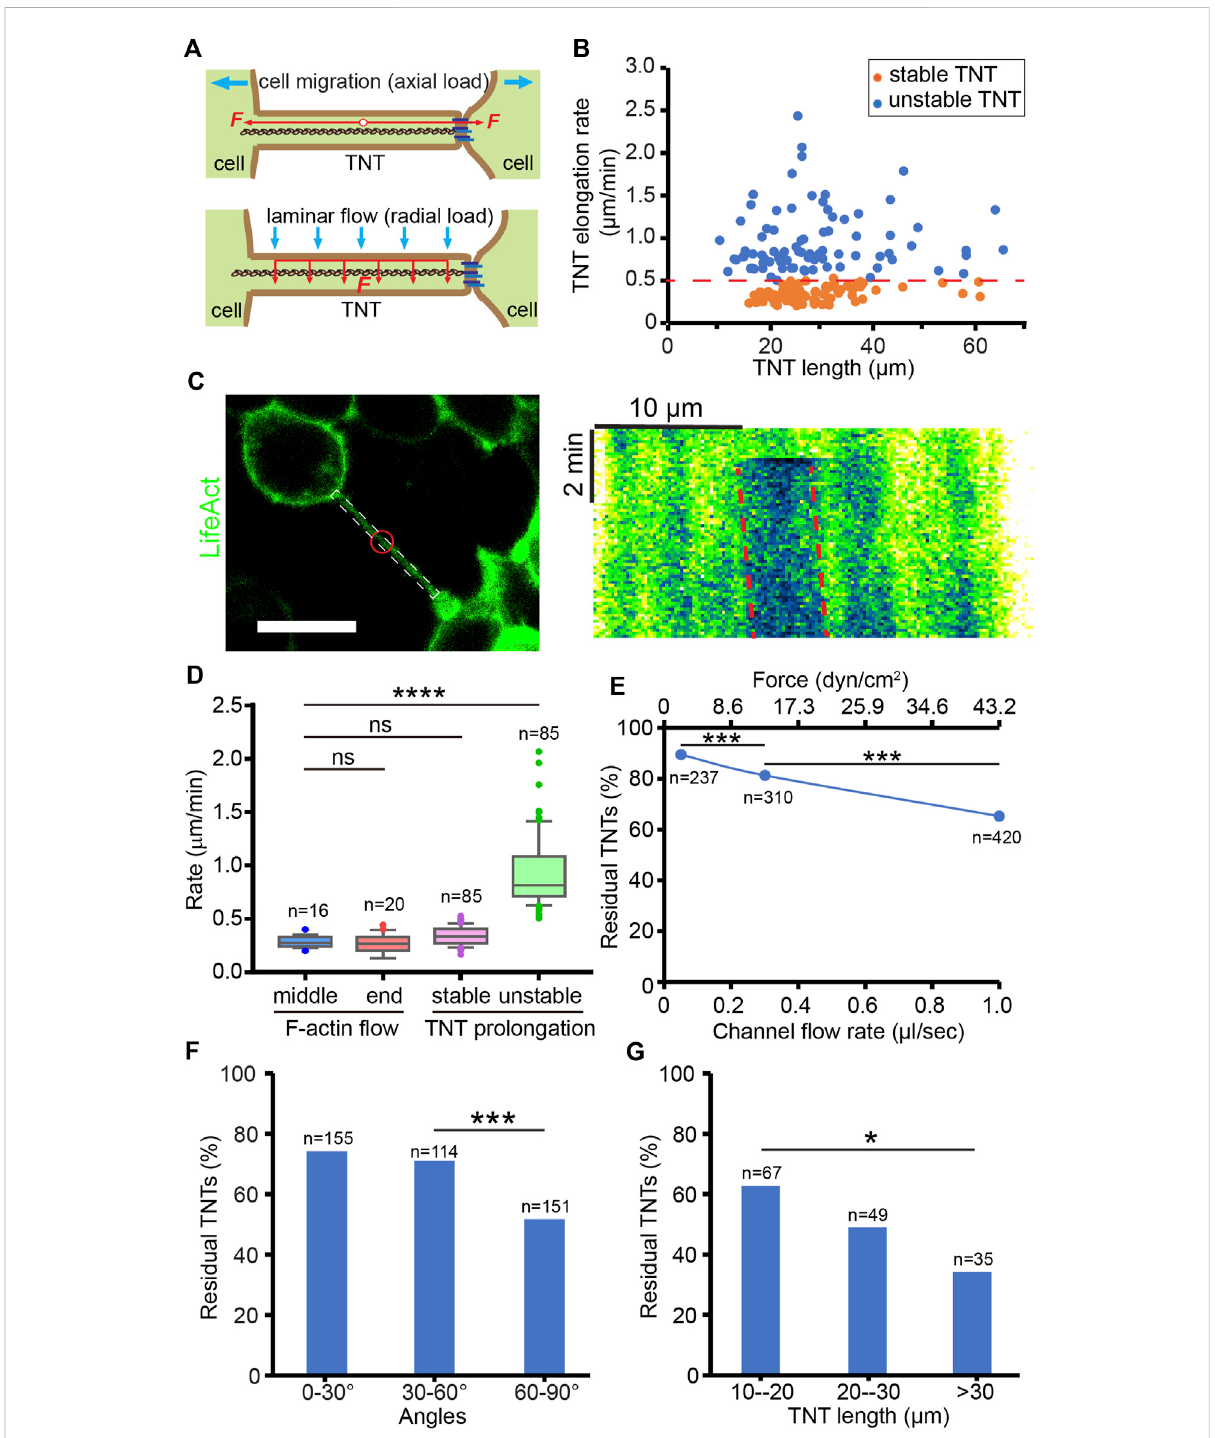
FIGURE 3 MechanicalstabilityofTNTs. (A) SchematicdiagramoftheaxialandradialloadofaTNT. (B) ElongationrateofstableandunstableTNTsinduced by TNT-connected cell migration. (C) Analysis of F-actin fl ow in a LifeAct-positive TNT. Red circle indicates the bleached area. Scale bar, 20 μ m. Kymograph generated from the white boxed area in the left image shows the movement of the bleached area (red dash lines) in the TNT, where the x-axis is the scale bar of length, and the y-axis is the scale bar of time. (D) Comparison of the fl ow rate of F-actin in the middle and end position of TNTs and the elongation rate of stable and unstable TNTs. (E) The percentage of residual TNTs after different fl ow stress treatments. (F) Effect of fl ow stress (1 μ l/s) on the number of TNTs with different angles. (G) Longer TNTs (60 – 90 ° ) are more mechanically sensitive to fl ow stress (1 μ